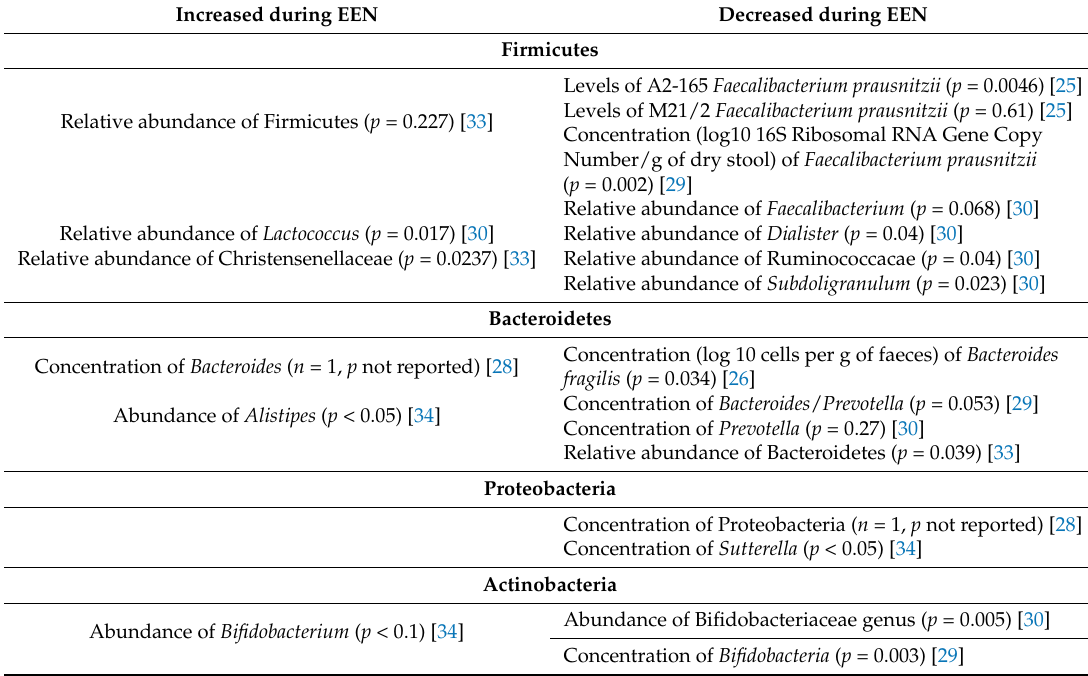
Table 2. Specific bacterial changes induced by exclusive enteral nutrition